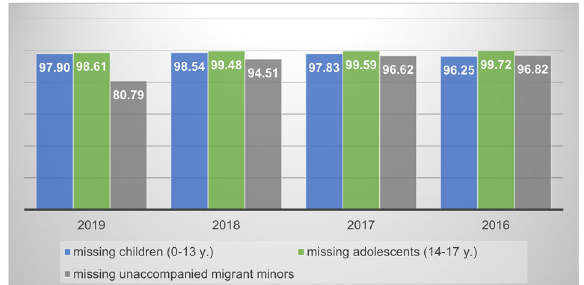
Fig. 1 Clearing rate for different groups of missing children in Germany. Missing children (0-13 y.) in blue, missing adolescents (14-17 y.) in green, and all missing unaccompanied migrant minors (0-17 y.) in